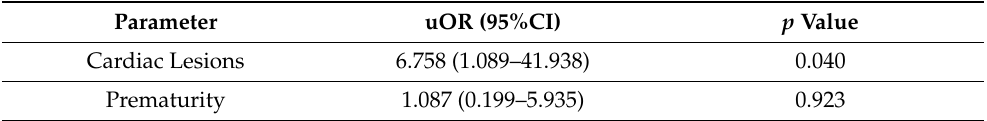
Table 6. Relationship between mortality and cardiac lesions and prematurity.